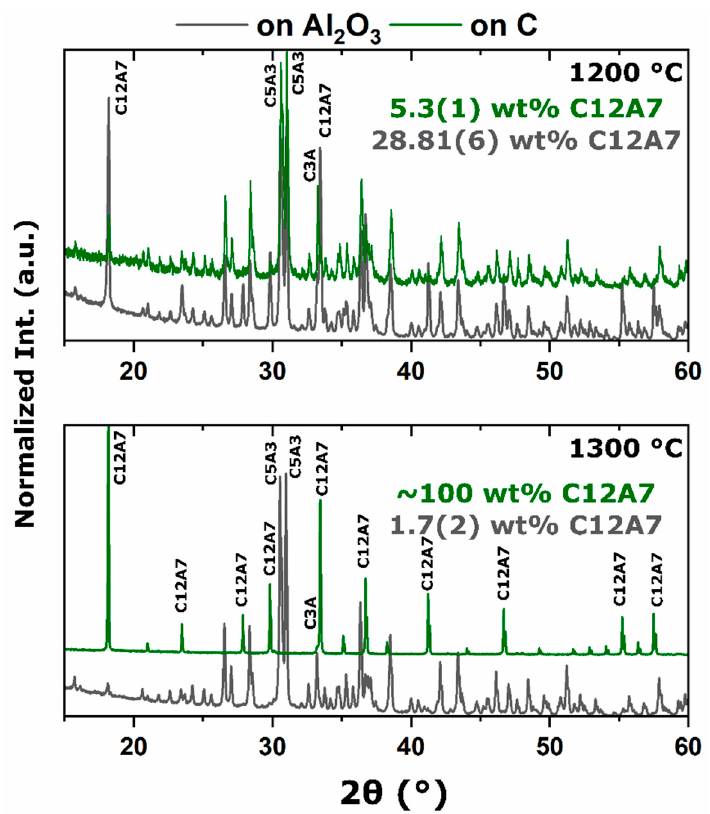
Figure 10 . Comparison between as-synthesized oxy-C12A7 processed on Al 2 O 3 (gray) vs carbon (green). The C5A3 and C3A decomposition pathway was observed in both scenarios.